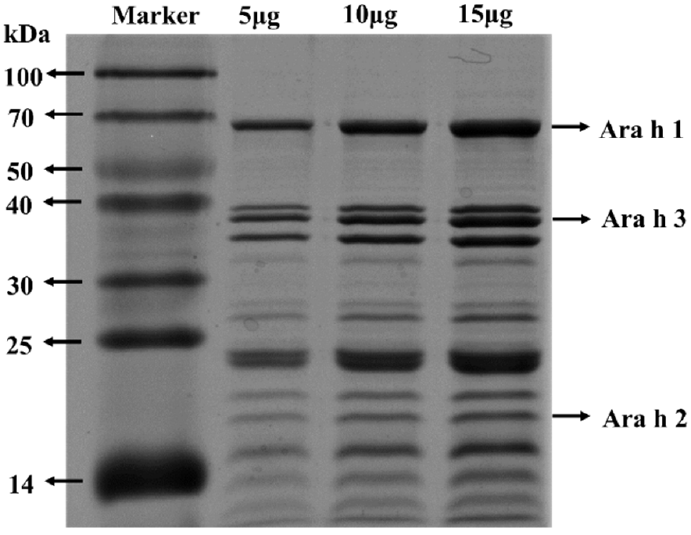
Figure 1. SDS − PAGE analysis of PE.